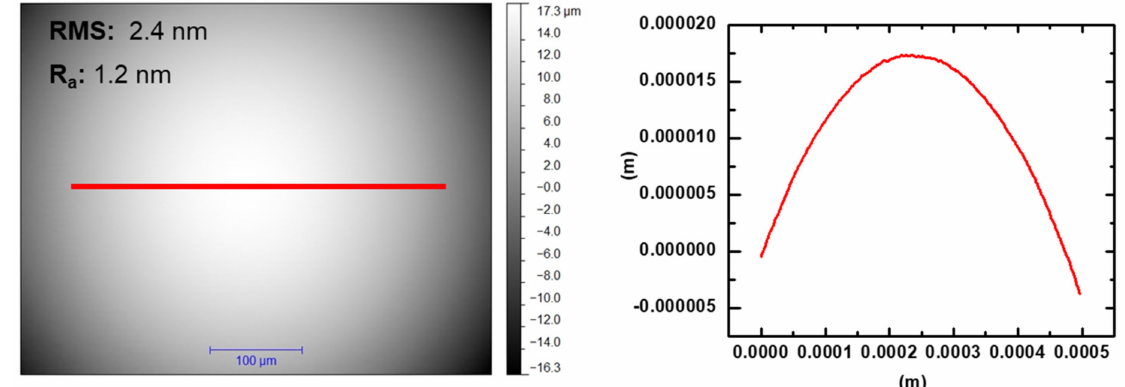
Figure 1. Diamond tip used for the on-line tribological testing in this study. The roughness (Ra) of the diamond tip was measured to be 1.2 nm by means of atomic force microscopy